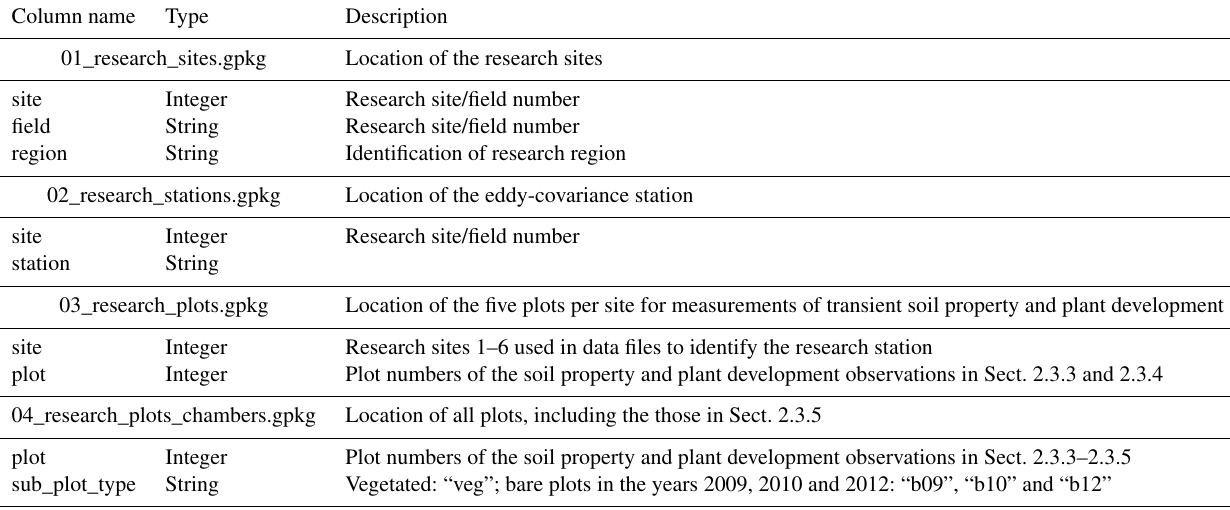
Table 19. Description of the attribute tables of the four GIS data model files which identify the location of the research areas, stations and plots in Tables 6–18. The main research plots are given in 03_research_plots.gpkg, identified as “veg” in the “sub_plot_type” column, and additionally “b09”, “b10” and “b12” relate to the bare-soil plots in